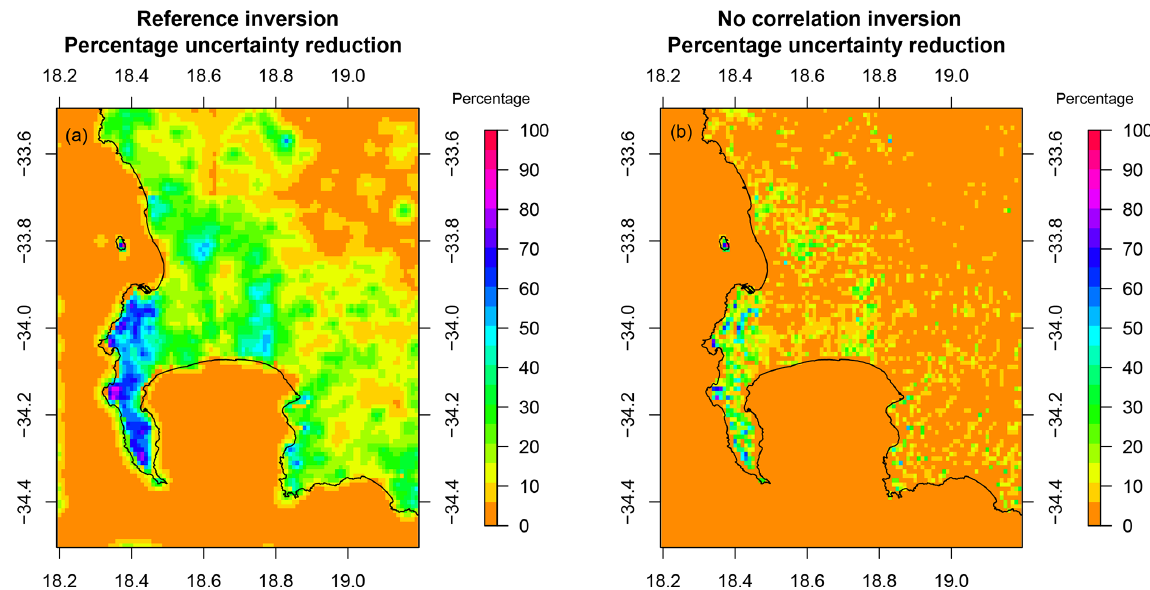
Figure 7. Spatial distribution in the pixel-level uncertainty reduction achieved by the inversion to the prior fluxes in May 2012 for the reference inversion (S0) (a) and to the no correlation inversion (S5) (b)